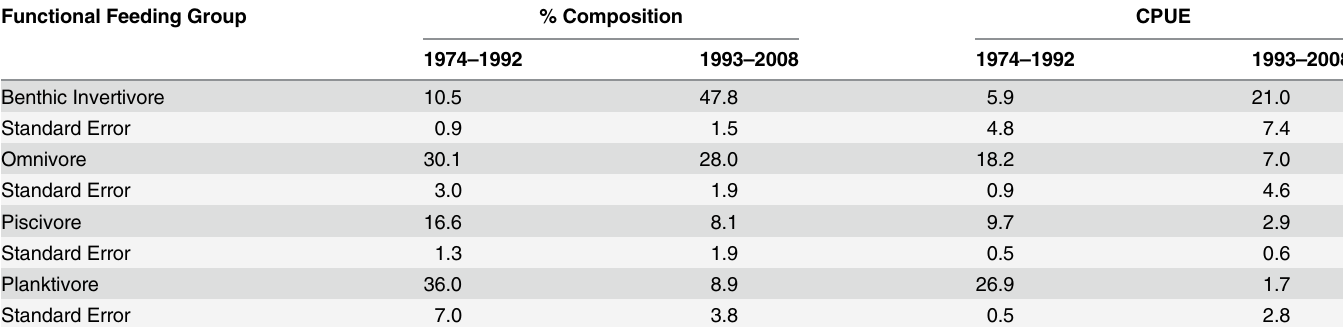
Table 2. Mean percent community composition and relative catch-per-unit-effort by functional feeding group, during time periods (1) 1974 – 1992 and (2) 1993 – 2008. Functional Feeding Group